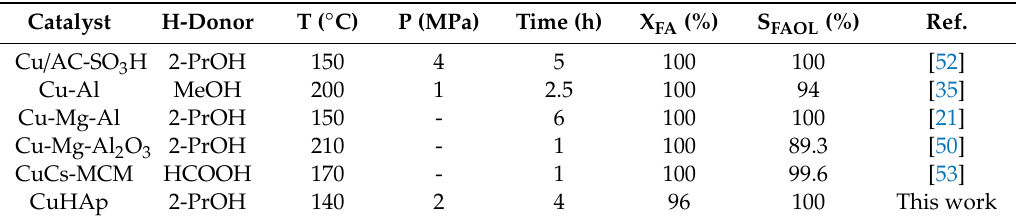
Figure 13. Recyclability test for 5CuHAp catalyst. Reaction Conditions: The catalyst amount (100 mg), 2-propanol (5 mL), FF (480 mg), reaction temperature—140 °C at 2 MPa N 2 pressure and reaction time—(4 h). Table 2. Comparison of the catalytic activity of Cu-based catalysts with various copper loadings published in the literature on CTH of FA to FAOL reaction.